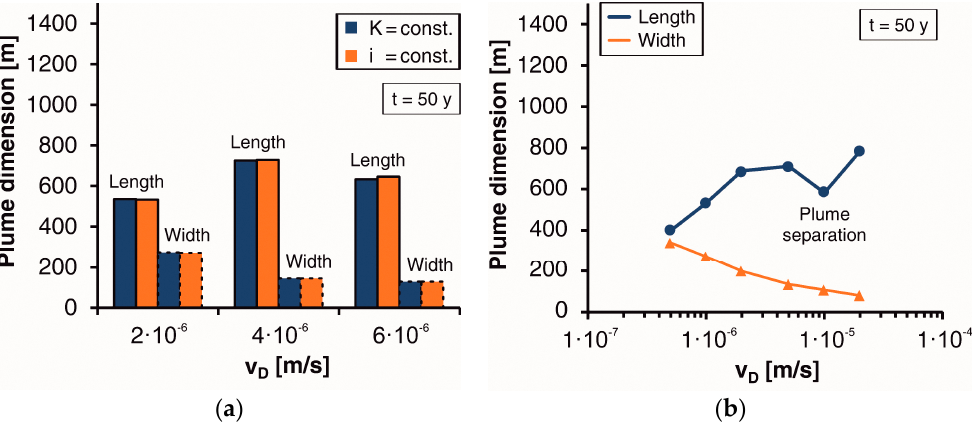
Figure 4. Plume dimensions after a 50 years simulation for different combinations of hydraulic conductivity (cid:1837) and gradient (cid:1861) ( a ) and for different values of Darcy velocity (cid:1874) (cid:3005) ( b ); isotherm ∆ T = 1